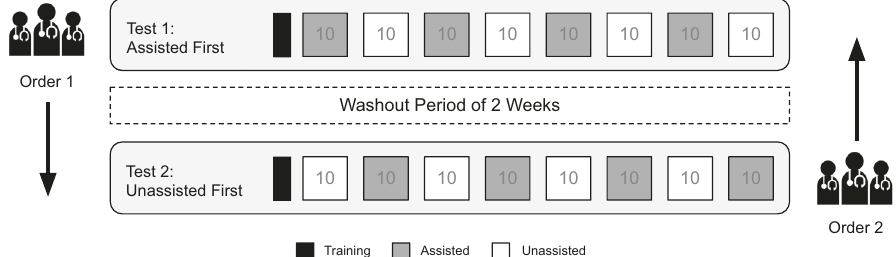
Fig. 2 Experimental design. Each of the 11 pathologists was randomly assigned to either test Order 1 or 2. Each test began with a brief practice block of 4 (2 HCC and 2 CC) practice whole-slide images (WSI), followed by 8 experiment blocks of 10 WSI each, with Order 1 beginning with assistance and Order 2 beginning without assistance. The same 80 experiment WSI were reviewed in the same sequence during Tests 1 and 2, across both test